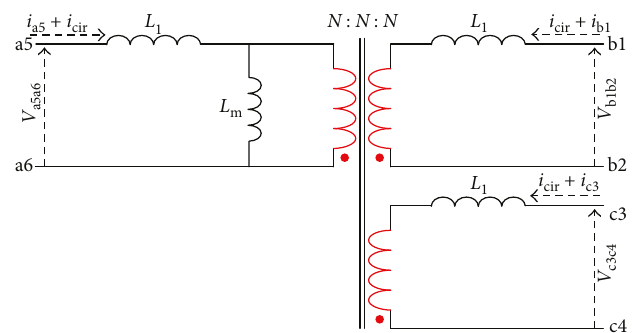
Figure 11: Equivalent circuit of the three-winding coupled